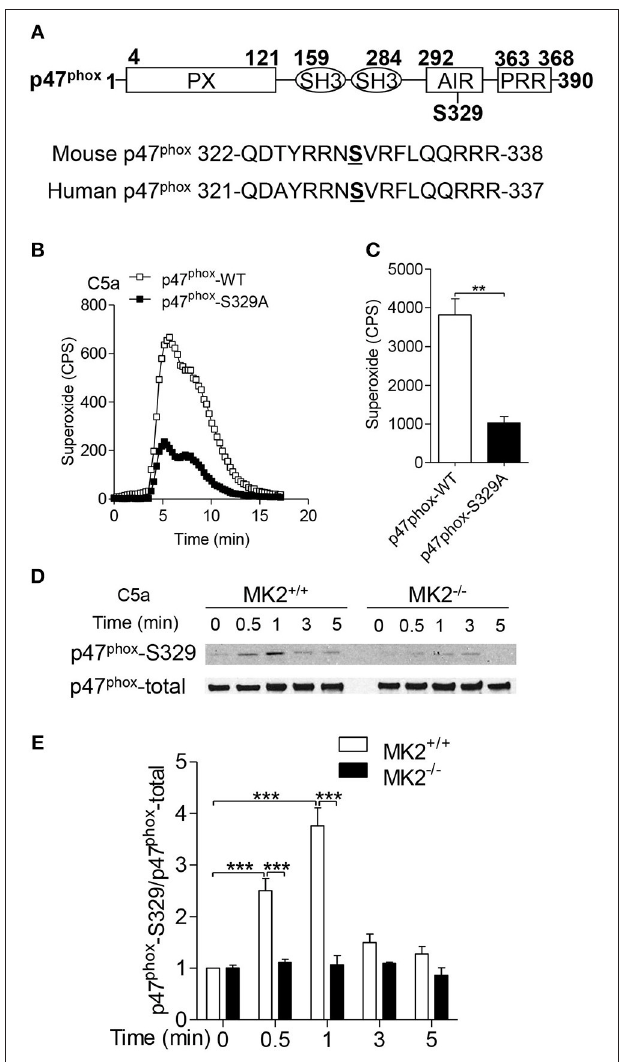
FIGURE 7 | MK2 regulated mouse p47 phox at Ser329 residue. (A) Alignment of sequence of human and mouse p47 phox proteins surrounding the potential MK2 phosphorylation site. (B) Neutrophils from p47 phox −− / – mice were transiently transfected with full-length p47phox or its S329 mutant for 6h, and followed challenge with 100nM of C5a. The production of superoxide production was measured as described. (C) The quantitative analysis was performed based on results of B superoxide. (D) Neutrophils from MK2 + / + and MK2 −− / – mice were challenged with 100nM of C5a for 0.5, 1, 3, and 5min, the phosphorylation of p47 phox (Ser329) was determined by western blotting with anti- p47phox-S329 antibody and p47 phox -total antibody. (E) Densitometry analysis was conducted to determine the relative level of p47 phox -S329. Data shown are means ± SEM from three independent experiments. ** P < 0.01, *** P <